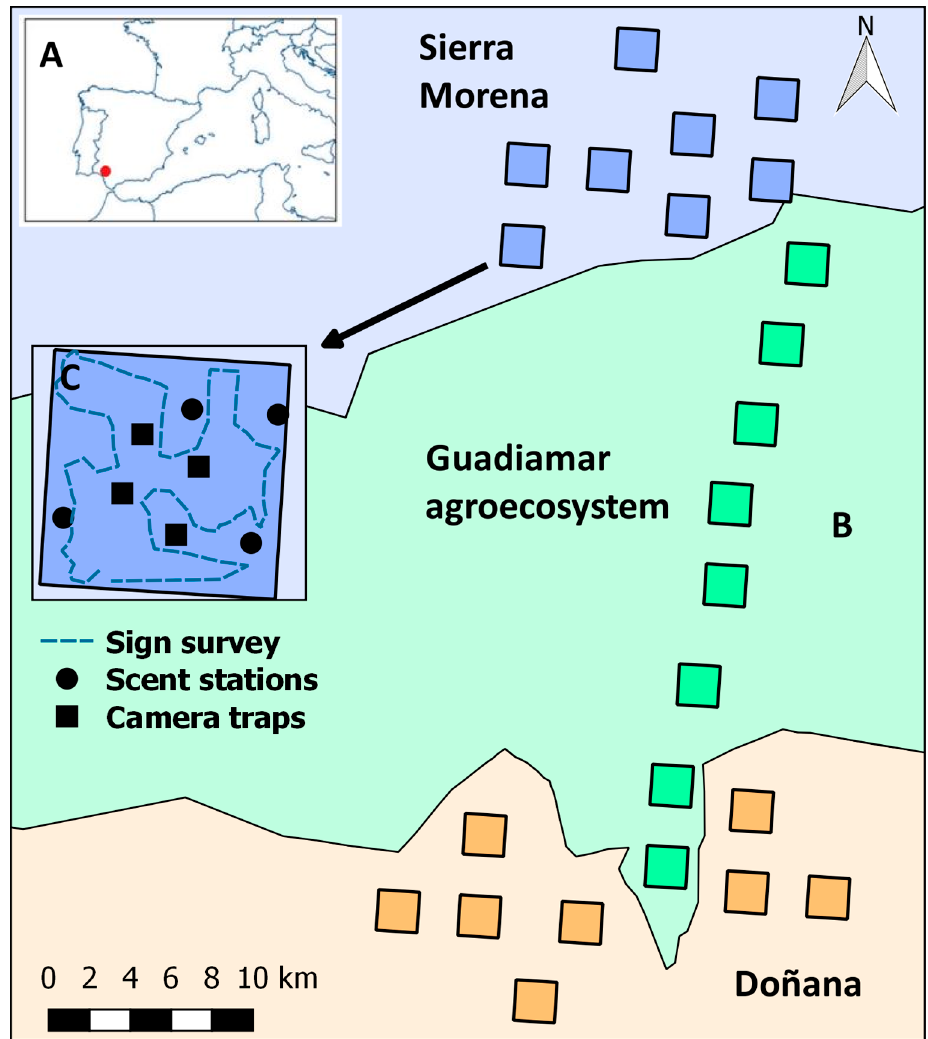
Figure 1. Study area. ( A ) Location of the study area in the lower Guadiamar basin, SW Spain. ( B ) Sketch of the study area showing the distribution of 4 km 2 sampling units ( n = 24) among three distinct landscapes (Sierra Morena, Guadiamar agroecosystem, and Doñana). ( C ) Distribution of sites with camera traps and scent stations, and an example of a sign survey conducted within one sampling unit.